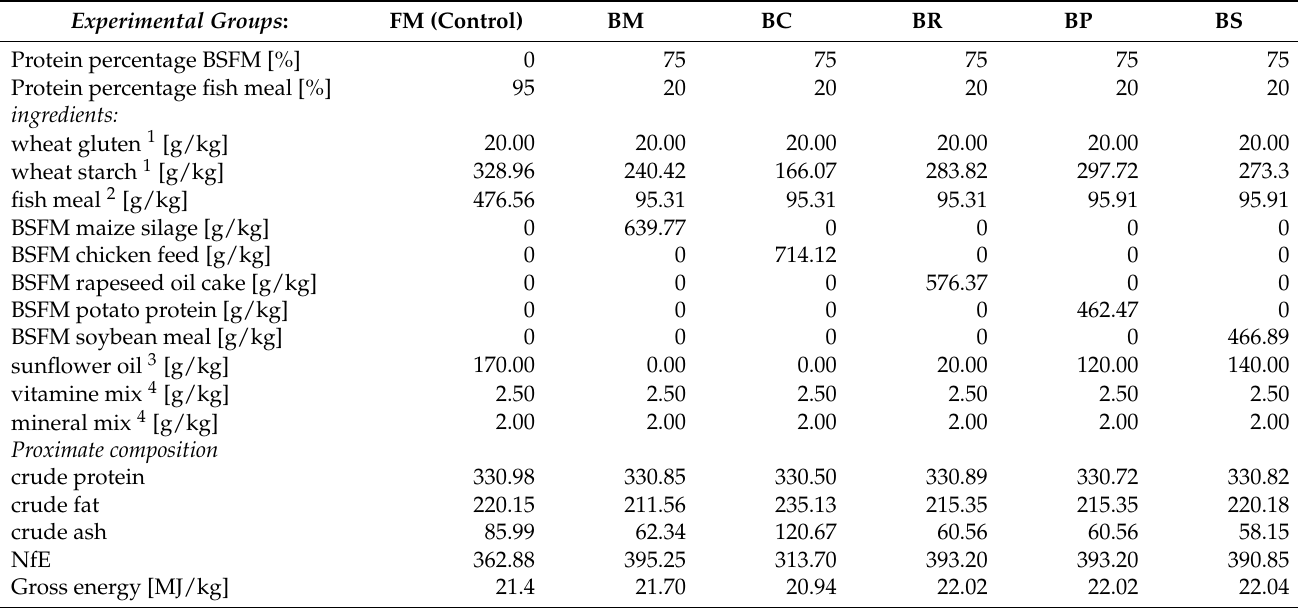
Table 2. Ingredients (g/kg) and gross composition (g/kg DM) of the fishmeal control and the five experimental diets. BSFM—Black soldier fly meal, NfE—nitrogen free extract (100 − (crude protein + crude fat + crude